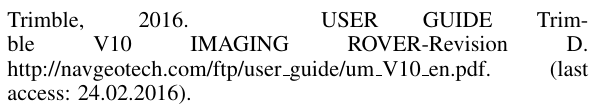
technologies improve the